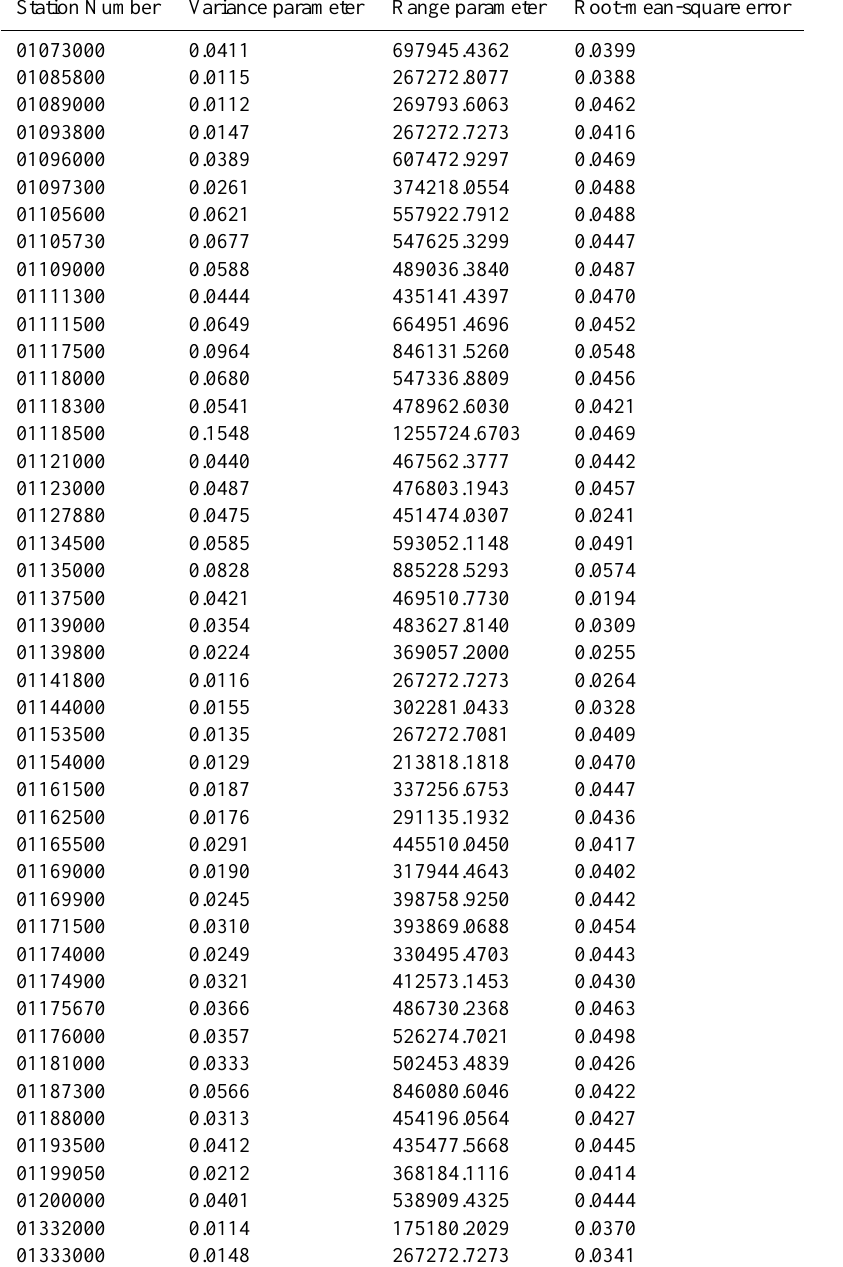
Table 3. Variogram model parameters and root-mean-square error value resulting from a leave-one-out cross validation of the variogram